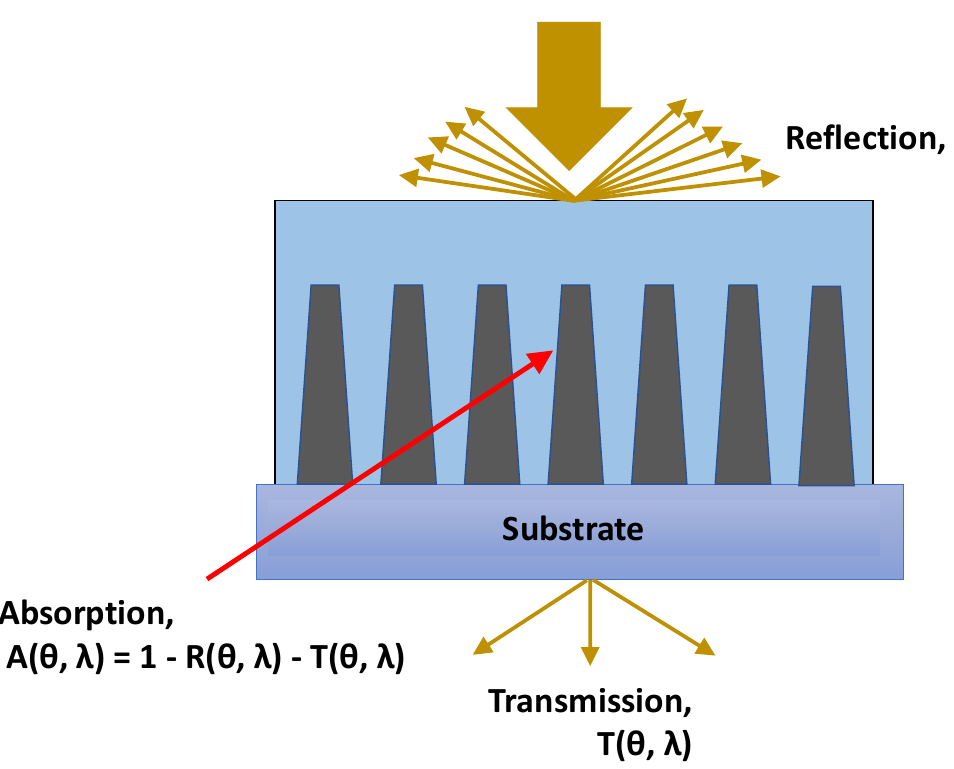
Figure 5. Schematic representation of optical R ( θ , λ ) , A ( θ , λ ) and T ( θ , λ ) through a PEDOT:PSS–SiNW hybrid solar